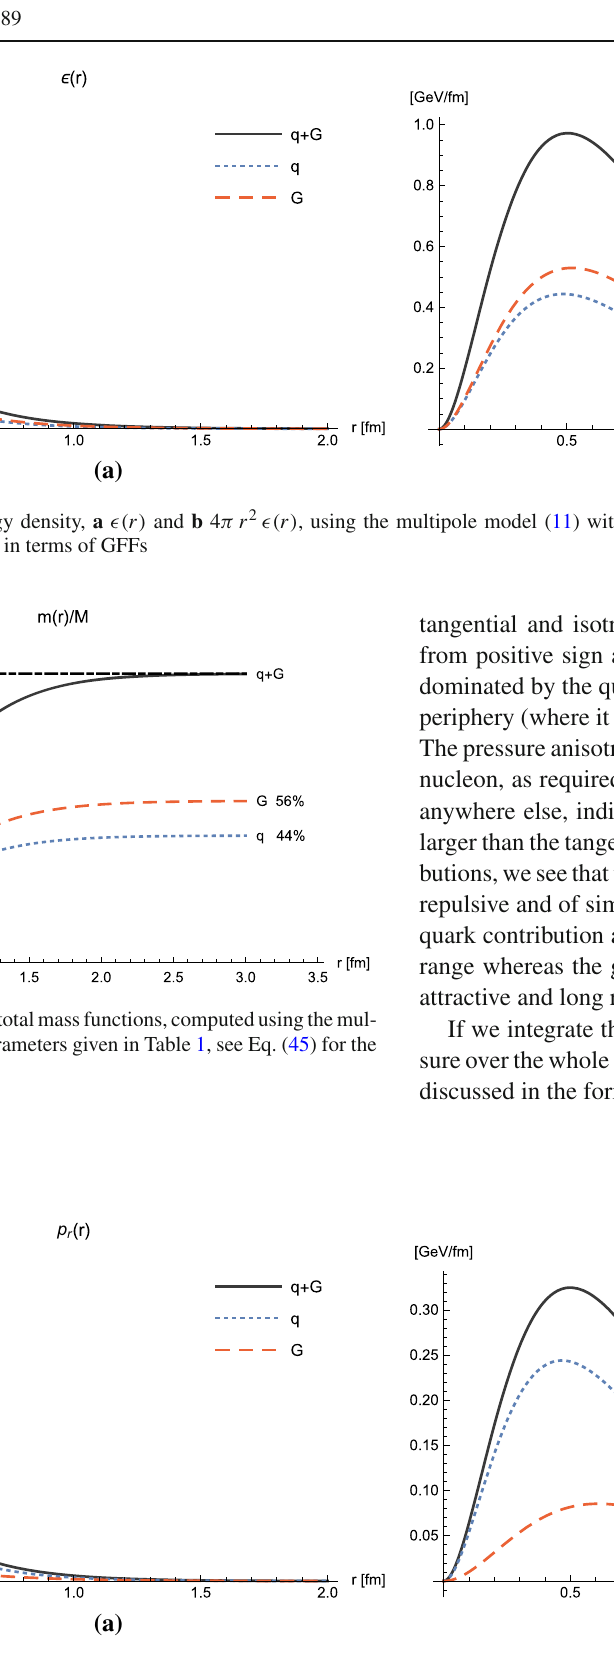
Fig. 4 Plots of the radial pressure, a p r ( r ) and b 4 π r 2 p r ( r ) , using the multipole model (11) with parameters given in Table 1, see Eq. (35) or Eq. (40) for definitions in terms of